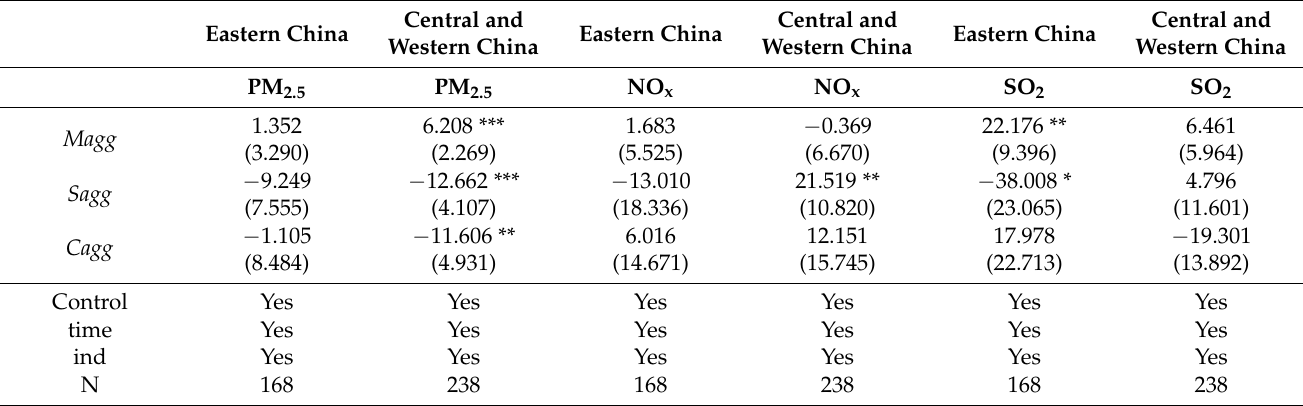
Table 6. Regression results of the effects of the agglomeration of manufacturing, the agglomeration of producer services, and the co-agglomeration on air pollution by regions. Central and Central and Central Eastern China Eastern China Western China